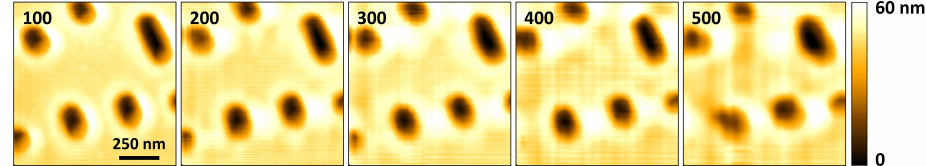
Figure 7. Topographical images of a 1 µ m × 1 µ m Blu-ray disk scan consisting of 200 × 200 pixels acquired at different line rates. The line rates, in Hz, are indicated in the top left corner of each